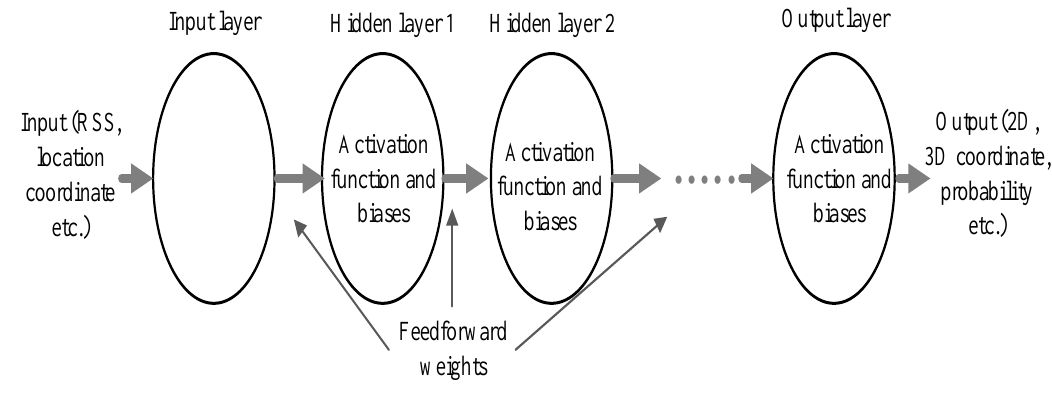
Figure 12. A typical architecture of multilayer perception